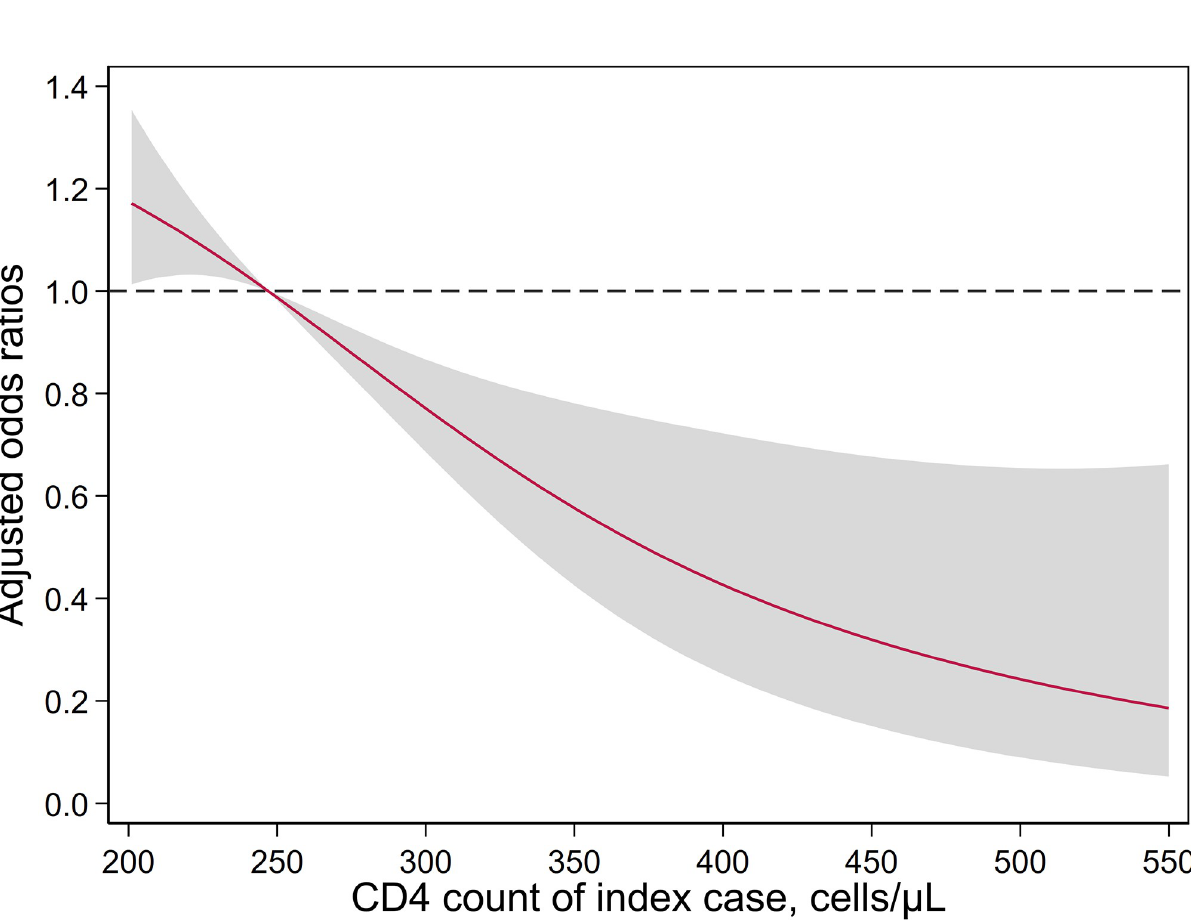
Fig 2. Adjusted odds ratios for HIV-positive status among exposed partners by CD4 count depletion of adults diagnosed with HIV during the survey (index case) in Malawi, Zambia, and Zimbabwe (2015–2016). Exposed partners of index cases with CD4 count of 250 cells/ μ L are the reference group. Odds ratios are adjusted for sex and country. Shaded area shows 95% confidence